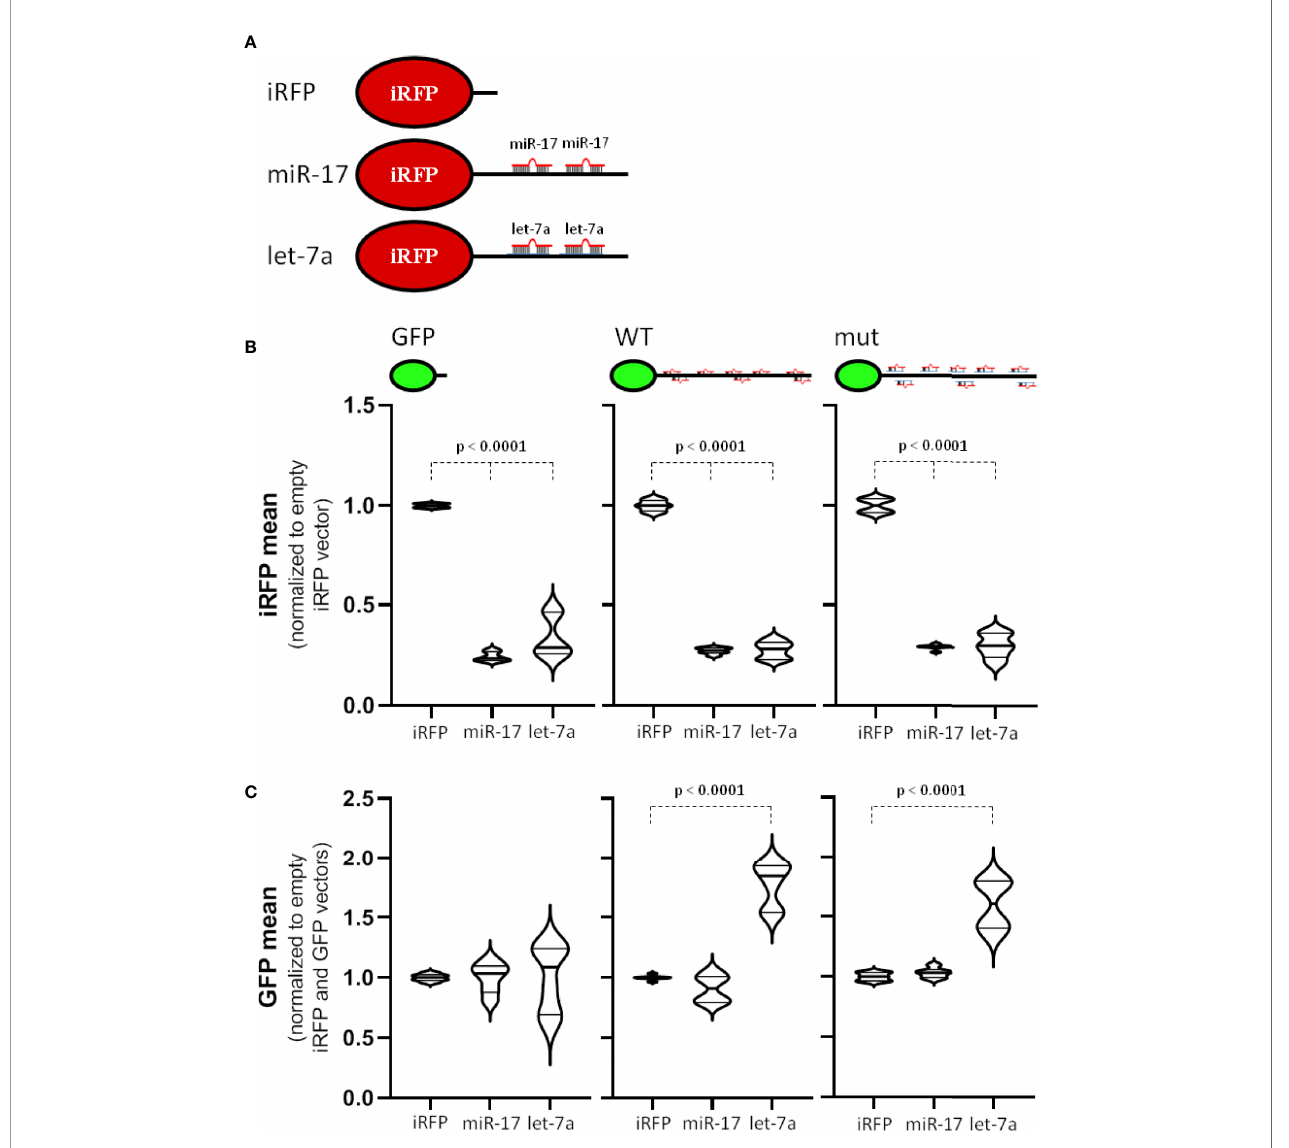
FIGURE 5 | miR-17 is a strong antagonizing miRNA for MYCN 3´UTR. (A) Scheme of used iRFP vectors. Control vector (iRFP) contains only a minimal 3´UTR. For miRNA antisense vectors, two perfectly complementary miRNA-targeting sites (miR-17 or let-7a) were cloned behind the iRFP open reading frame. (B, C) Transfected BE(2)-C cell were analyzed by fl ow cytometry. GFP and iRFP double positive cells were analyzed to determine the in fl uence of the MYCN 3´UTR to the antisense reporter (B) or the in fl uence of the miRNA antisense reporter to the MYCN 3´UTR (C) upon normalization (n = 3). Statistical signi fi cance was determined by Student ’ s t-test (p-values